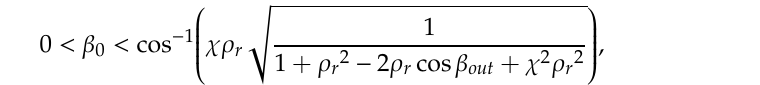
Figure 11. Schematic representation of the design algorithm.